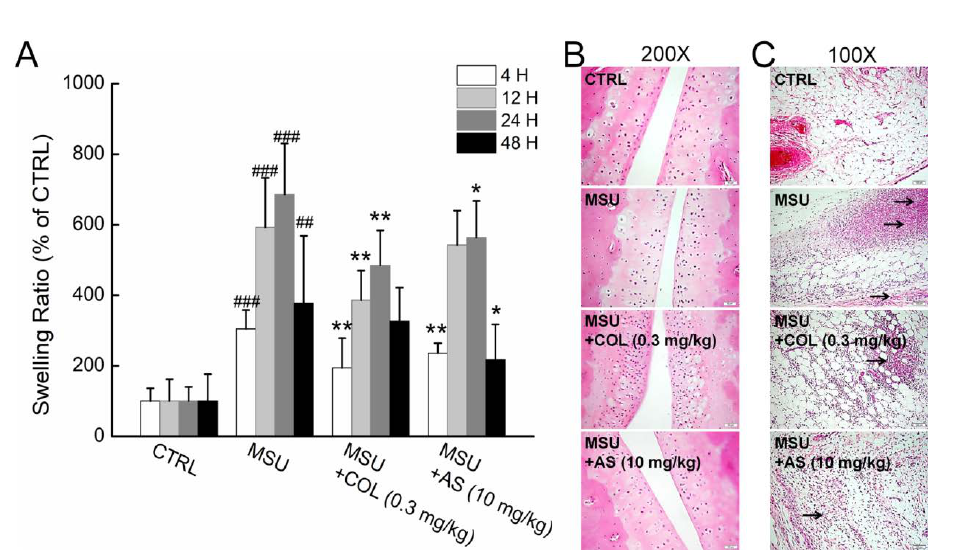
Figure 3: The anti-inflammation effects of AS on rats with acute gouty arthritis established via intraarticularly injection with 100 μg of MSU at the right ankle joint. ( A ) AS reduced the swelling ratio of ankle joints in rats. The percentage of swelling ratio of other groups were calculated compared with CTRL rats, which was considered to be 100%. Data are analyzed using a one-way ANOVA and expressed as mean ± S.D.